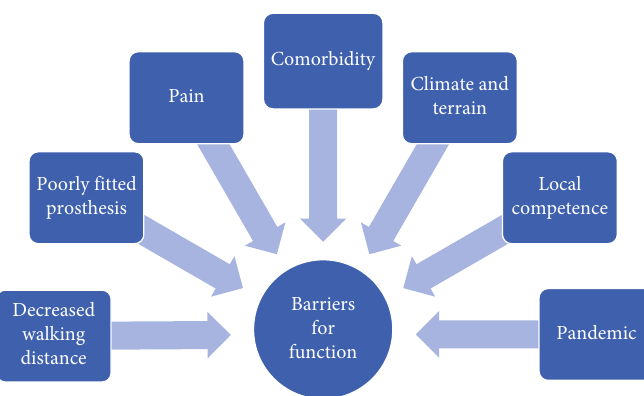
functionDecreased walking